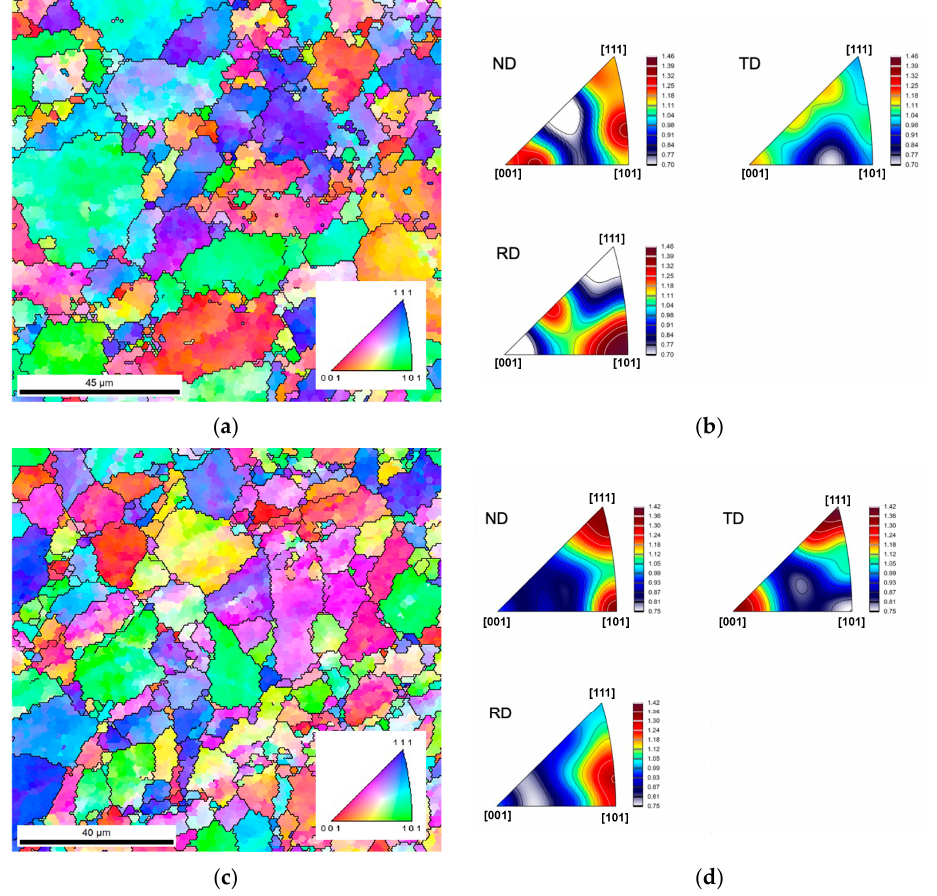
Figure 11. ( a , c ) IPF maps and ( b , d ) IPF of the sintered Al ( above ) and Al/CNTs ( below ) samples.